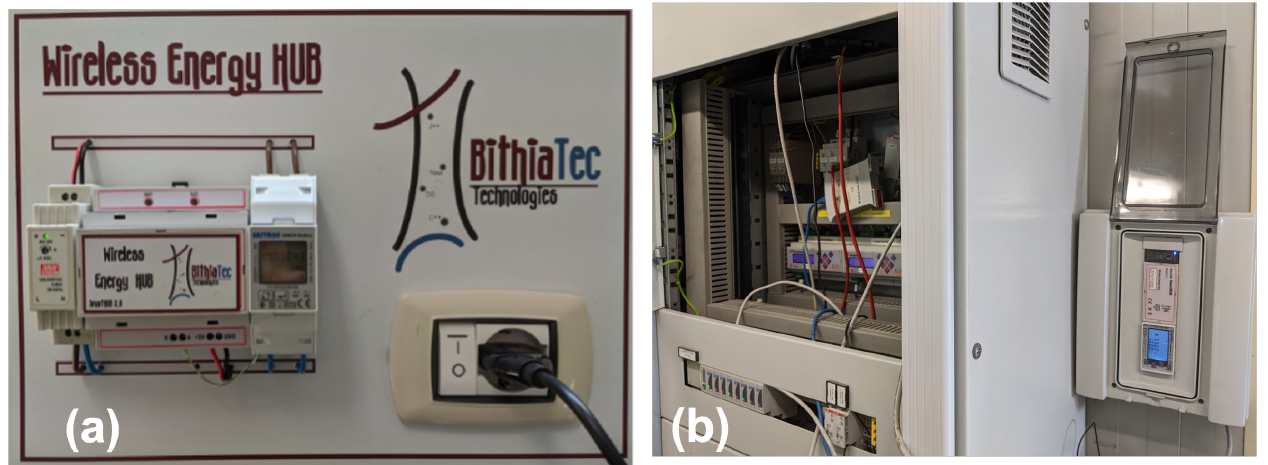
Figure 5. ( a ), a picture of the blockchain-enabled Smart Meters (BSM) used in this paper: a prototype of Bithiatec PRO blockchain-enabled smart meter. ( b ), a picture of the on-site installation of the